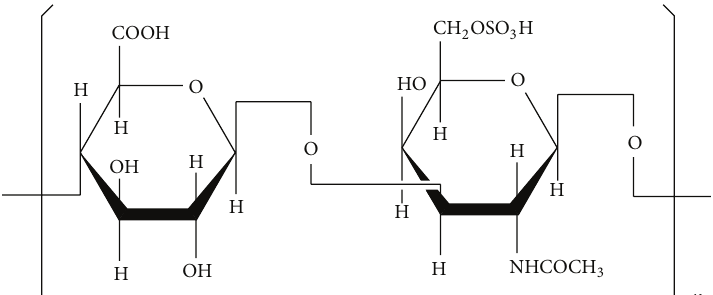
Figure 8: Chemical structure of chondroitin sulfate C (C 6 S).